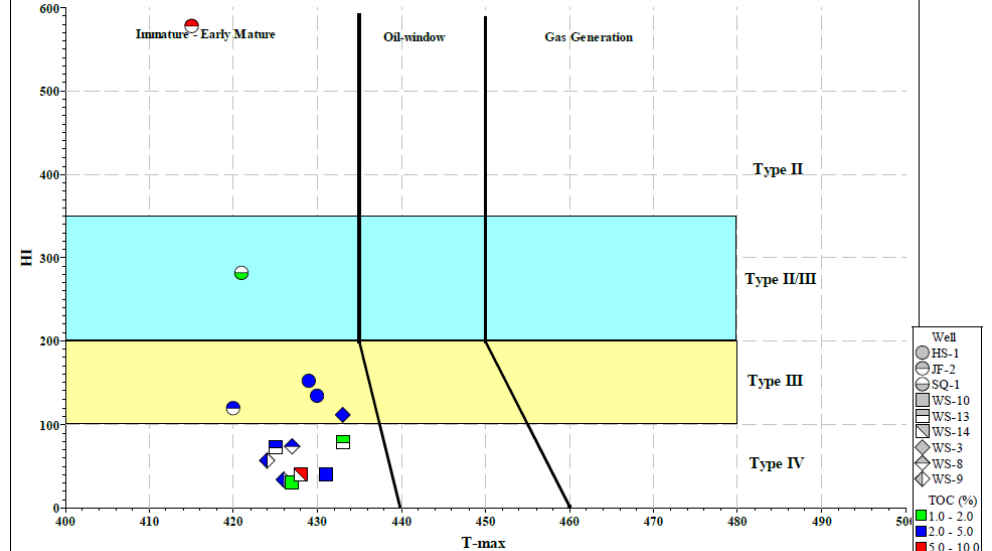
Figure 8. An alternating source quality interpretation T max -HI for characterizing kerogen type and